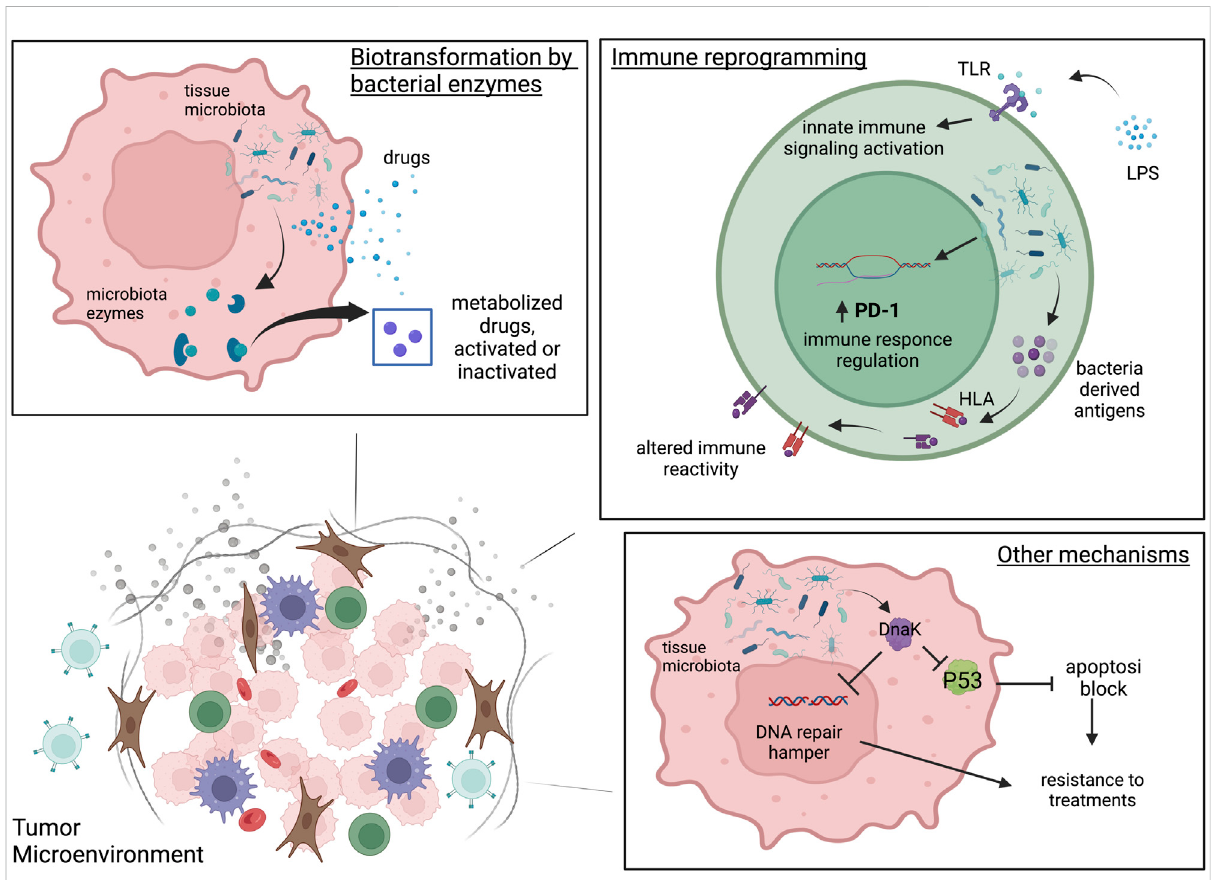
The three microbiota-mediated mechanisms of in fl uence on cancer therapies. Biotransformation by bacterial enzymes. In tumor cell intratumoral bacteria can produce enzymes able to metabolize drugs and consequently activate or inactivate them. Immune reprogramming. IntratumoralbacteriacanreprogramtheTMEimmunitythroughtheactivationofTollLikereceptorsandtheinnateimmunityactivation.Intratumoral microbiota can modulate PD-1 expression on CD4 + CD8+T cells and may affect T cell immune reactivity and immune function by introducing antigens derivedfrombacteria ontumorHLA-IandHLA-IImoleculesbothontumor cellsandantigenpresentingcells.Othermechanisms.Intumor cells the intratumoral bacteria can interfere with therapy response through the alteration of apoptosis, cell cycle and DNA repair by proteins of bacterial origin very similar to their human counterparts such as DnaK. Created with